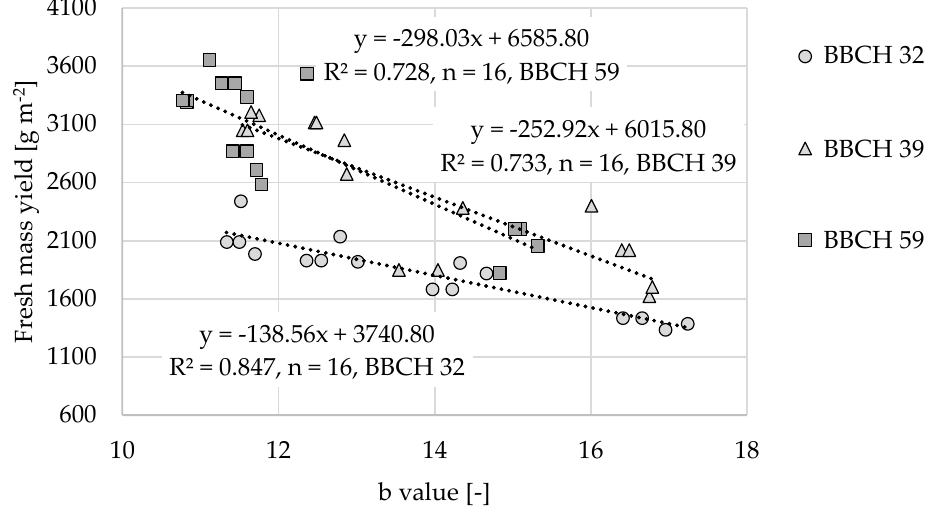
Figure 10. Linear regression models of the fresh mass versus reflection values of the b values for the growth stages BBCH 32 ( p = 2.259 × 10 − 20 ), BBCH 39 ( p = 8.455 × 10 − 15 ), and BBCH 59 ( p = 1.322 × 10 − 14 ).